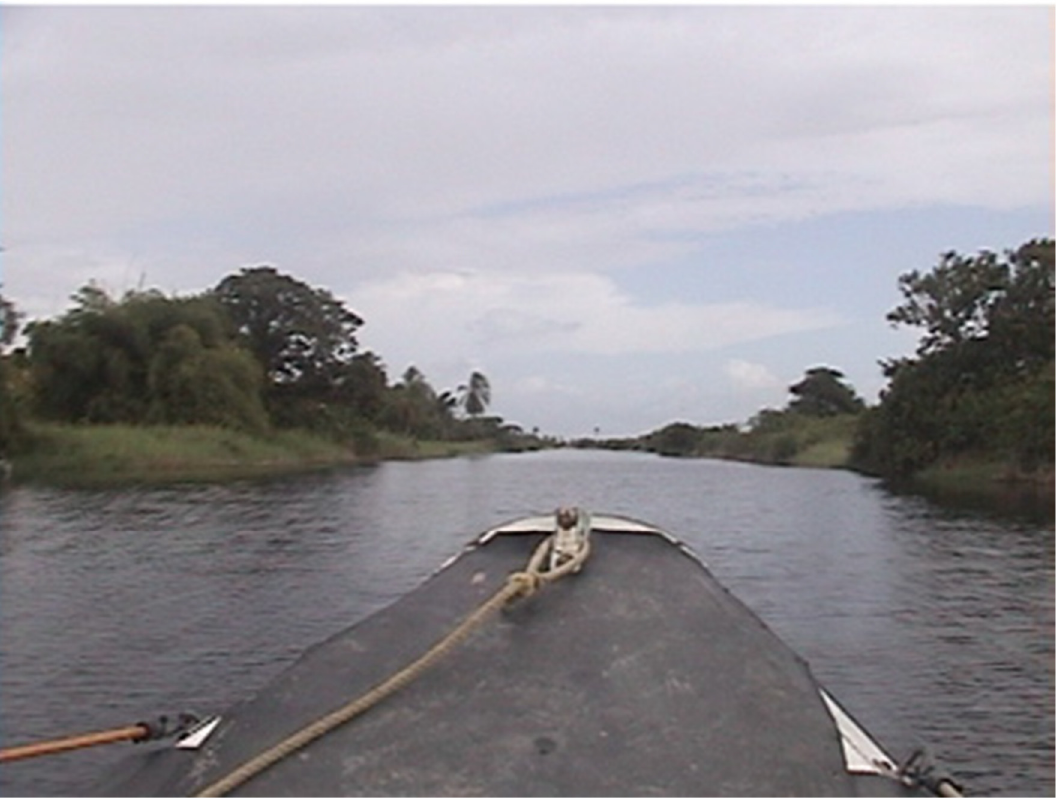
Figure 2. Maya Mackrandilal, Kal/Pani (still from video), 2014. SD video with sound, 8:52 min.